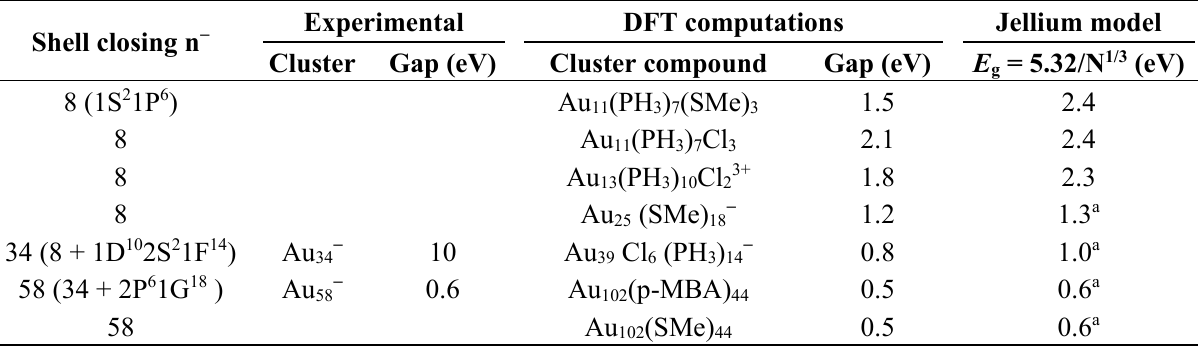
Table 2. Compilation of data from [20] combining experimental data for gas-phase Au AQCL anions obtained by photoelectron spectroscopy and DFT computations for a set of ligand protected Au AQCLs, compared to the jellium model predictions (for AuN AQCLs with N > 25, an anharmonicity correction of − 0.4 (eV) is applied). Experimental DFT computations Jellium model Shell closing n − Cluster Gap (eV) Cluster compound Gap (eV) E g = 5.32/N 1/3 (eV) 8 (1S 2 1P 6 )